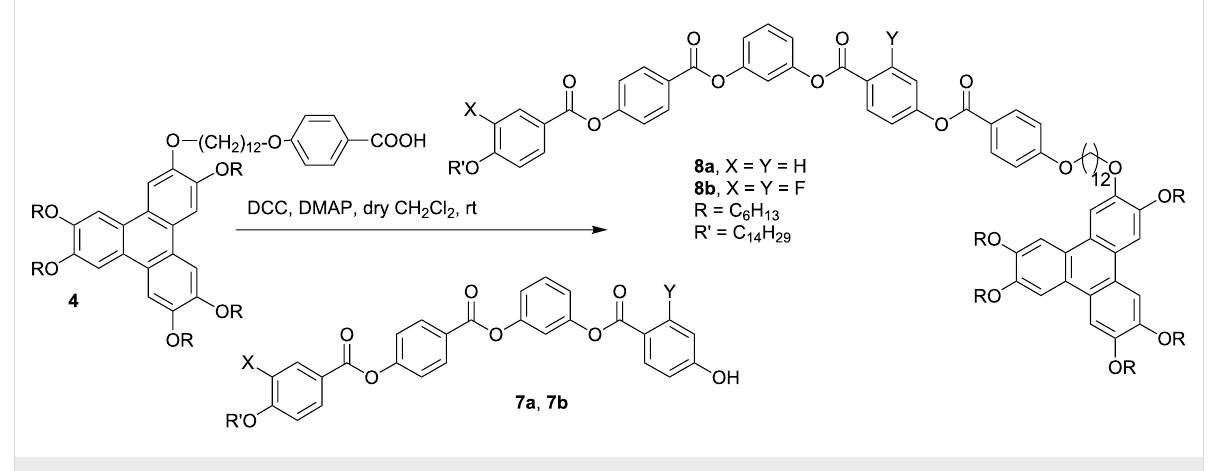
Scheme 2: Synthesis of banana-discotic dimers.